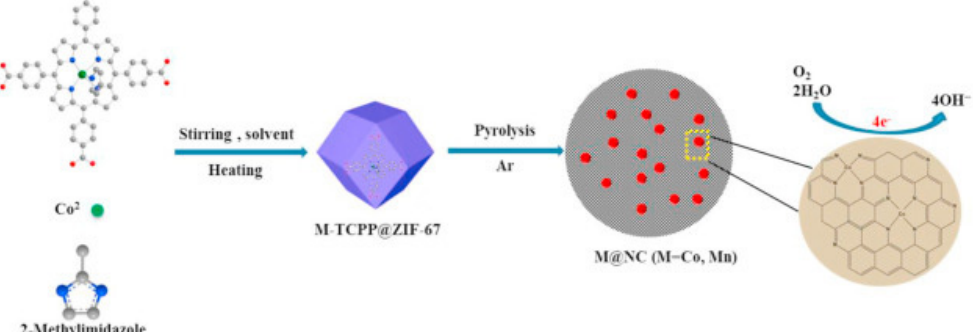
Figure 8. Fabrication of M@NC (M = Mn and Co) catalysts used for electrocatalysis oxygen reduction reaction in alkaline medium. Reprinted with permission from [59].